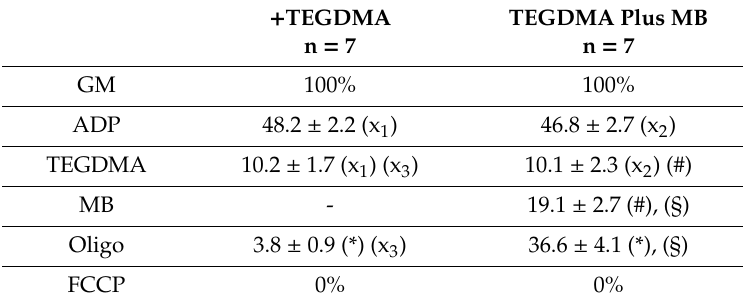
section, and are depicted on the Figure 1B. Percentage of membrane potential was calculated as described in the Materials and Methods section. 100% indicates hyperpolarization, 0% indicates complete depolarization in